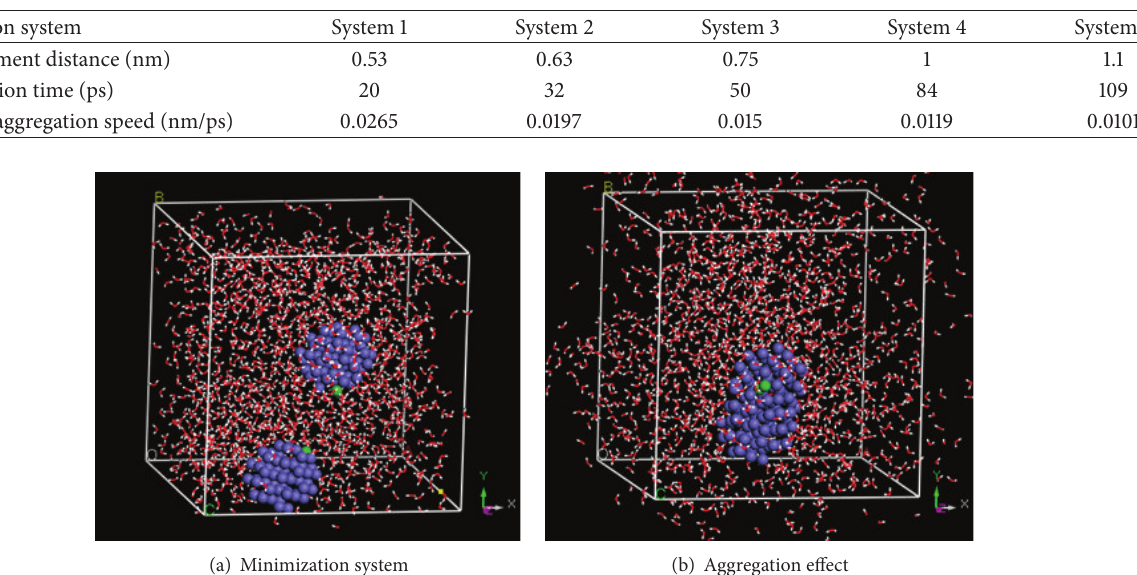
Figure 6: Conformations of minimization system and aggregation effect of system